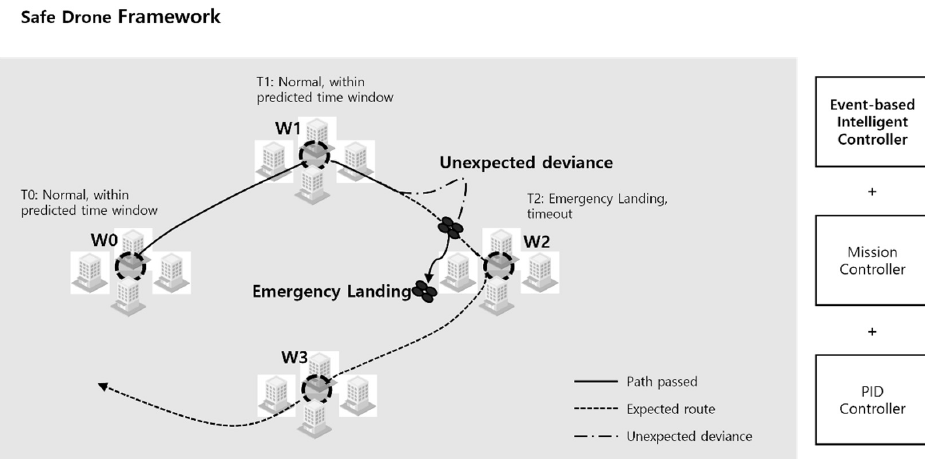
Figure 1. Proposed safe drone framework. The event-based intelligent controller is designed to detect emergency situations with time-window check results and perform an emergency landing if needed. We mounted our event-based controller on top of lower-level controllers and designed it to work in conjunction. Our proposing method requires waypoint-based predefined flight plans in order to calculate the expected time-window and diagnose abnormality.